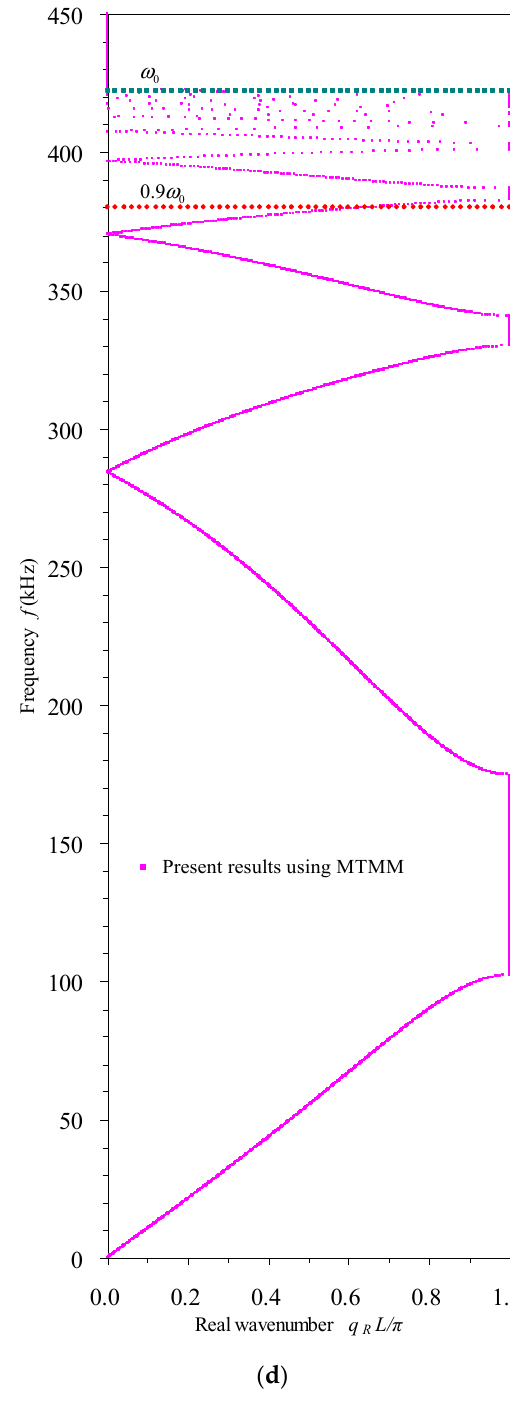
Figure 4. The phase constant spectra of the periodic PZT-5H piezoelectric rod covered by brass electrodes with periodic electrical boundaries: ( a ) electric-open condition; ( b ) applied electric capacity condition with C “ α A { l “ 1.02 ˆ 10 ´ 10 F; ( c ) electric-short condition; and ( d ) applied feedback control condition with K g “ 5 ˆ 10 8 V {